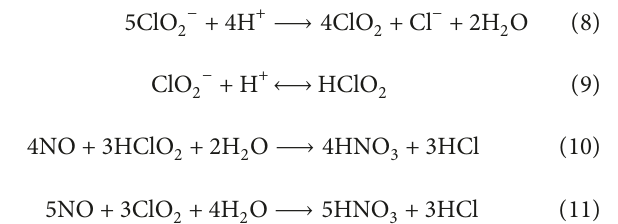
x concentrations at inlet and outlet ports of the RPB reactor (a) and NO x removal efficiencies (b) with rotational